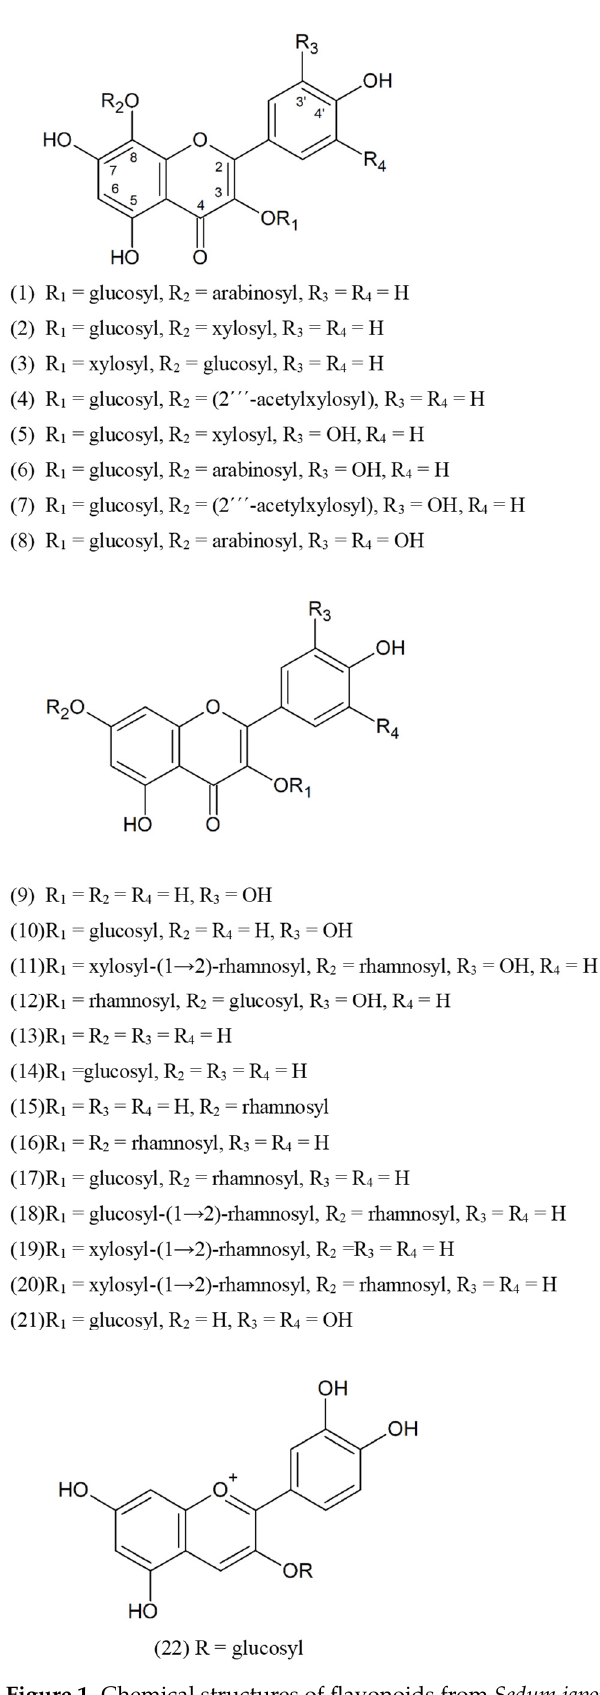
Figure 1. Chemical structures of flavonoids from Sedum japonicum subsp. oryzifolium .